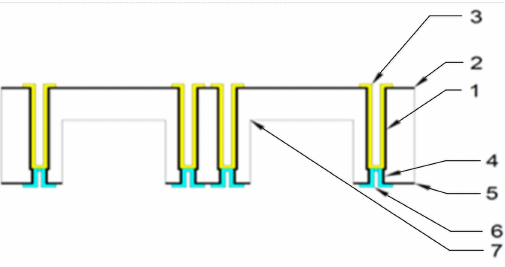
Figure 5. Cross section of the cap HR-Si interposer wafer.